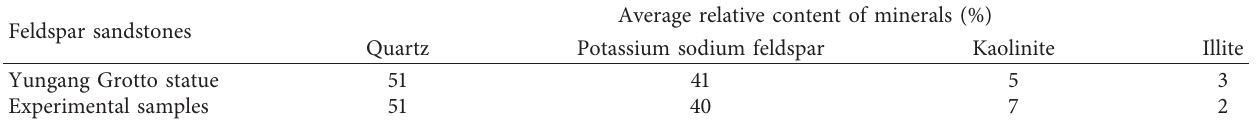
Table 1: Average relative content of the minerals of the feldspar sandstones. Feldspar sandstones